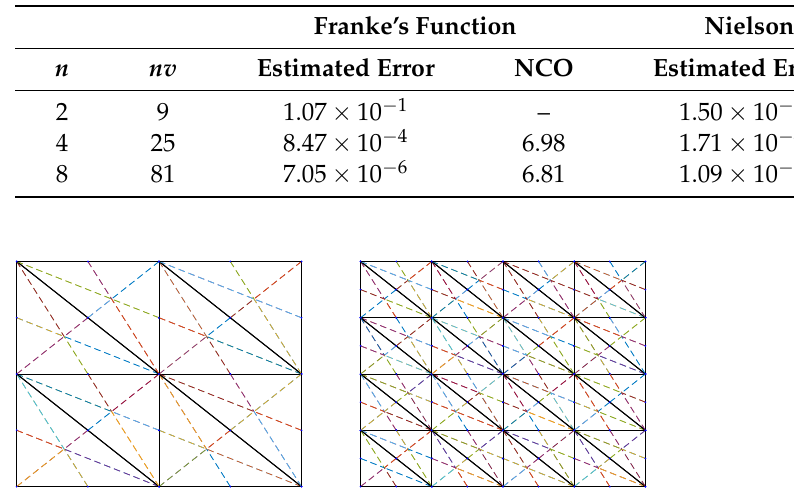
Figure 15. Meshes for n = 2 m , 1 ≤ m ≤